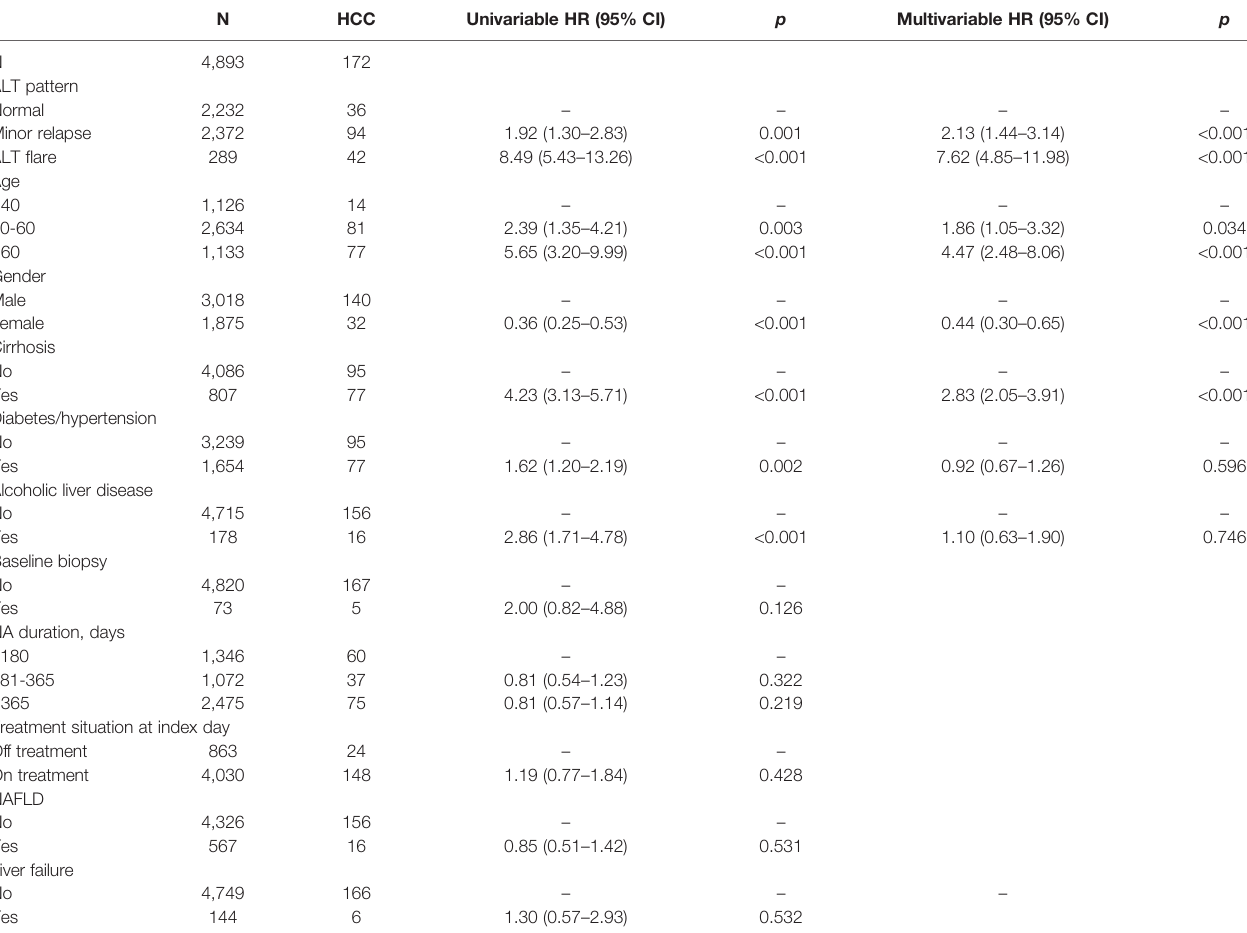
TABLE 5 | Cox proportional hazard model of the association between ALT fl are and hepatocellular carcinoma in the US